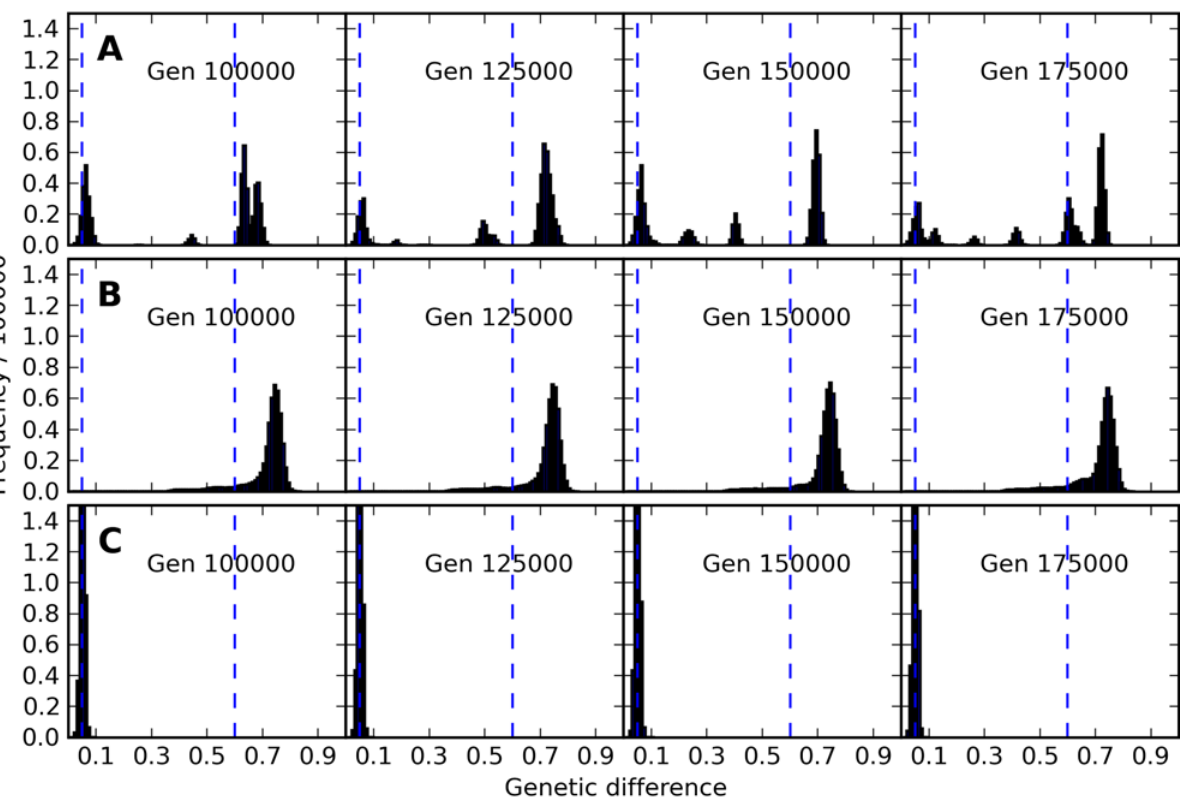
Figure 4. Time Series of Pair Similarity Histograms. Snapshots of frequency histograms of the genetic difference of randomly selected pairs of individuals from three runs, setting (A) low movement distance d =1.5 with outbreeding depression h =0.6, (B) low movement distance d =1.5 with no outbreeding depression, and (C) larger movement distance d =5 with h =0.6. Plots are shown horizontally for a sequence of four generations (100,000, 125,000, 150,000, and 175,000) within each of the conditions A, B, and C. The number of peaks does not correspond directly to the number of distinct genetic types in the population (see text for discussion of this important point). Video animations in MPEG format of the time course of the pair similarity histograms are available online in Video S1, Video S2, and Video S3. These animations are far more revealing of the fascinating time dynamics of these simulations than the small sequence of frames shown above.